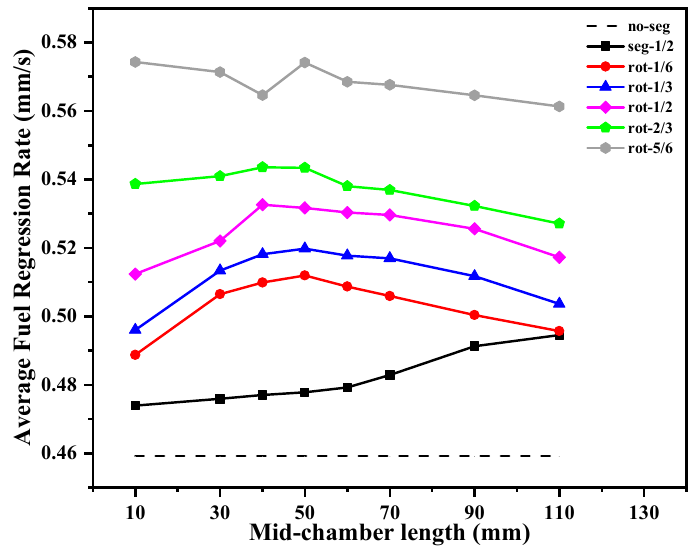
Figure 25. Average fuel regression rates in the fore-section grain for various cases.